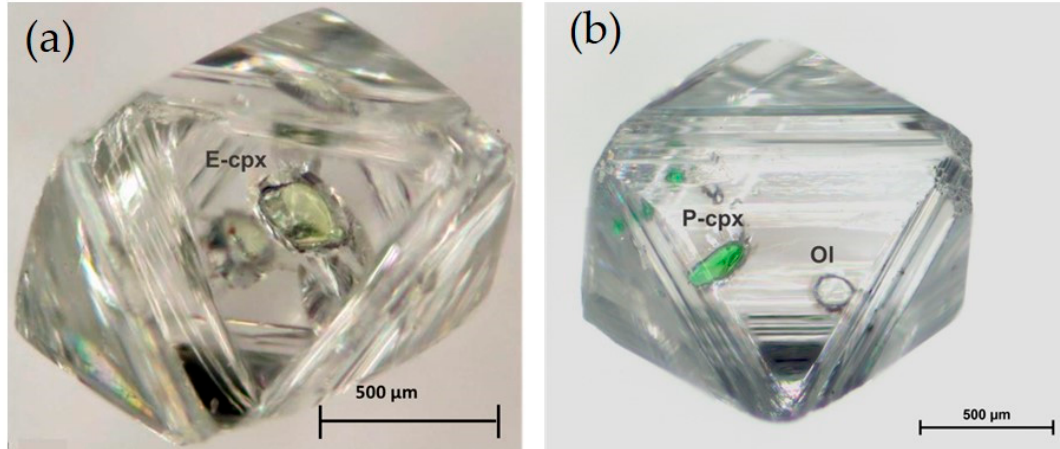
Figure 2. Two octahedral diamonds with ( a ) peridotite and ( b ) eclogite inclusion associations; E-cpx—eclogite clinopyroxene, P-cpx—peridotite clinopyroxene, Ol—olivine.